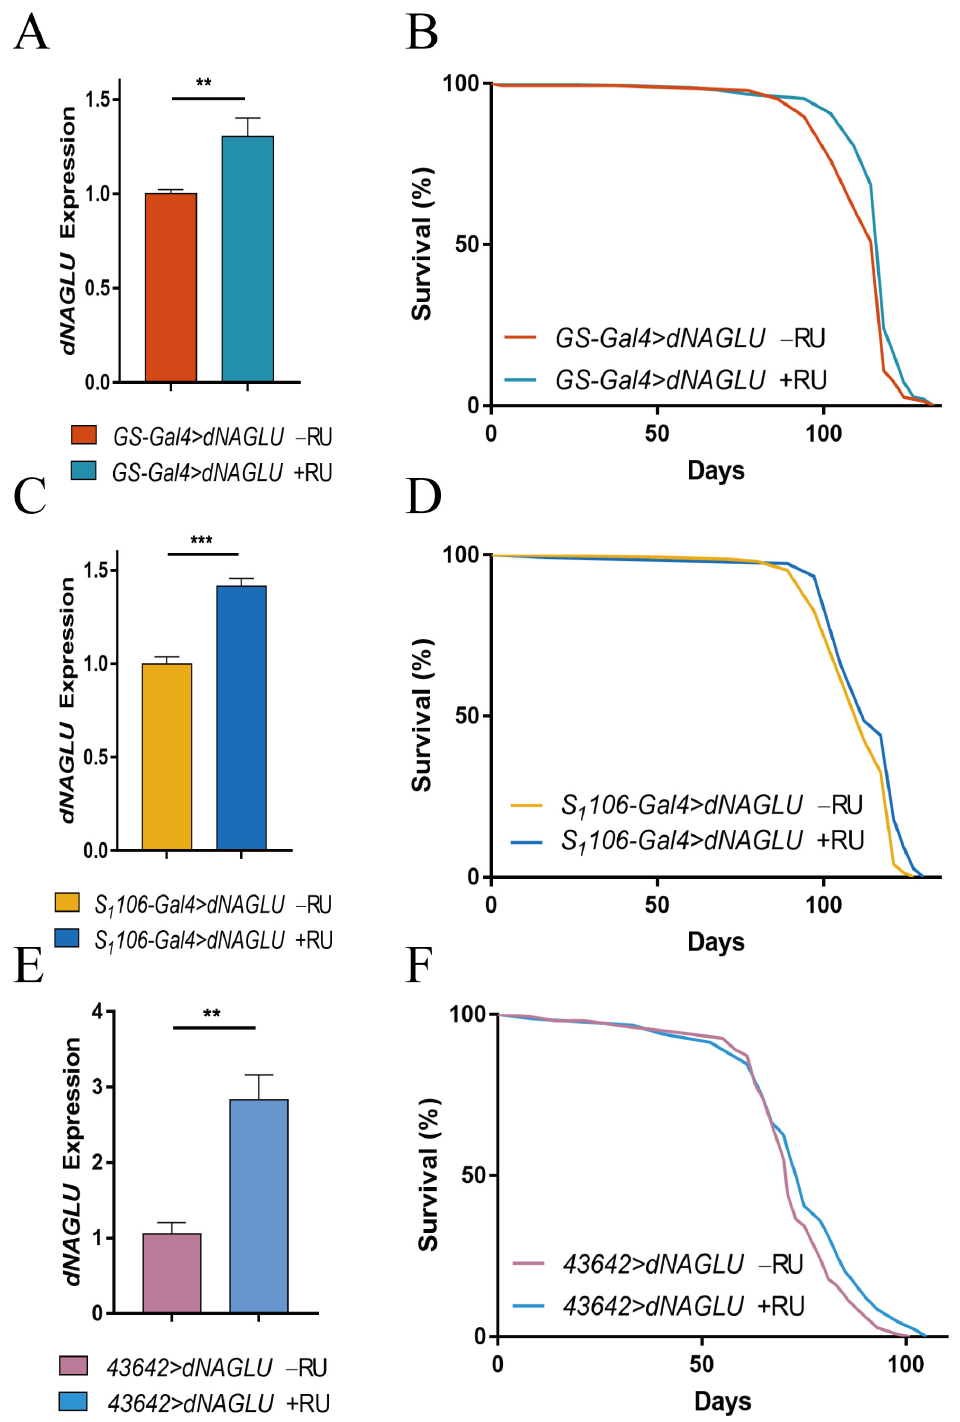
Figure 2. Effects of dNAGLU overexpression on the lifespan in Drosophila : ( A ) qRT-PCR validation for expression of dNAGLU in Drosophila whole body; ( B ) survival curves of Drosophila overexpressing dNAGLU in the whole body, p = 0.0004; ( C ) qRT-PCR validation for expression of dNAGLU in Drosophila fat body; ( D ) survival curves of Drosophila overexpressing dNAGLU in the fat body, p = 0.0008; ( E ) qRT-PCR validation for expression of dNAGLU in Drosophila nervous system; ( F ) survival curves of Drosophila overexpressing dNAGLU in the nervours system, p = 0.0195. A 5% or lower p value is considered to be statistically significant using Student’s t -test, ** p < 0.01, *** p < 0.001. All survival data were analyzed with the log-rank test.